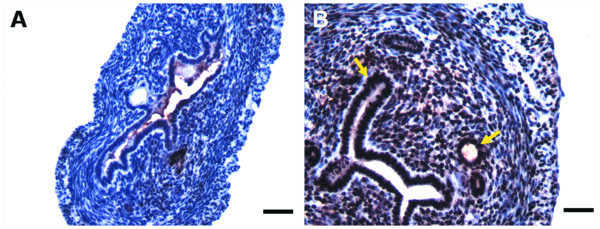
Immunohistochemical detection of differential Pcna protein levels due to TAM. Twelve-hour vehicle (A) and TAM (B) treated uteri sections were immunohistochemically stained (NovaRED®) with Pcna specific antibodies. Treated samples have darker nuclear staining, indicating greater levels of Pcna protein expression, in agreement with the histological assessment and changes in gene expression associated with cell proliferation. Increased Pcna expression is more pronounced in the luminal and glandular epithelium, and stroma (arrows). Tissues were counter-stained with hematoxylin. Images are representative of four biological replicates. Bars represent 20 μm.